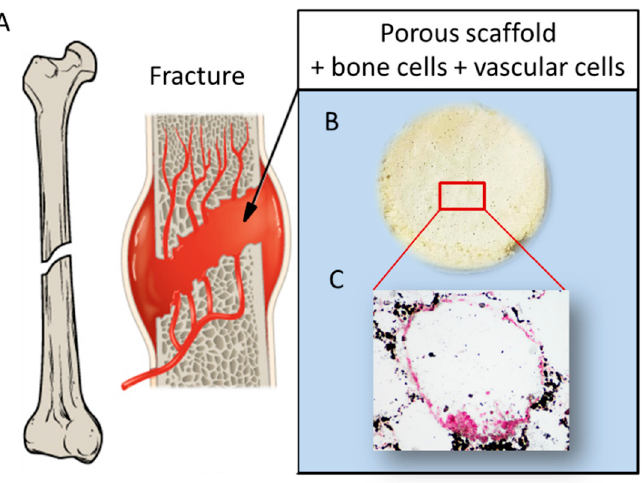
Figure 8. Schematic showing: ( A ) a fracture involving bone tissue including vasculature; ( B ) a porous scaffold; and ( C ) histological analysis displaying a pore colonized by a dual cell population: osteoblast-like cells producing mineral matrix (by von Kossa staining positive, in black), and endothelial cells surrounding the pore walls (von Kossa staining negative, in red), reprinted with permission and adapted from [101], under John Wiley and Sons Copyright Clearance Center (license number 5170741359741).